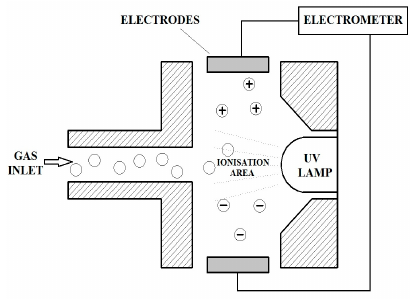
Figure 7. Scheme of photoionization sensor design.